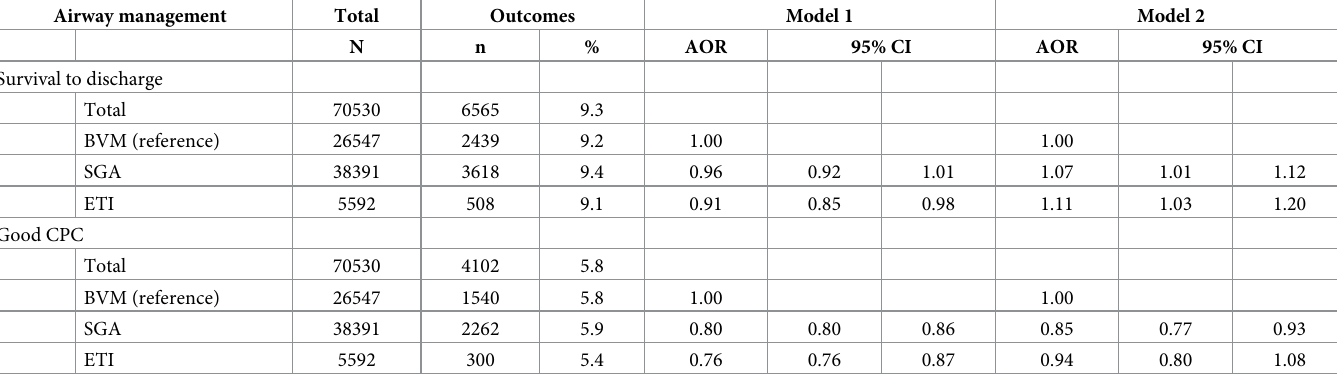
Table 3. Multivariable adjusted logistic regression analysis model for outcomes by airway management technique. Airway management